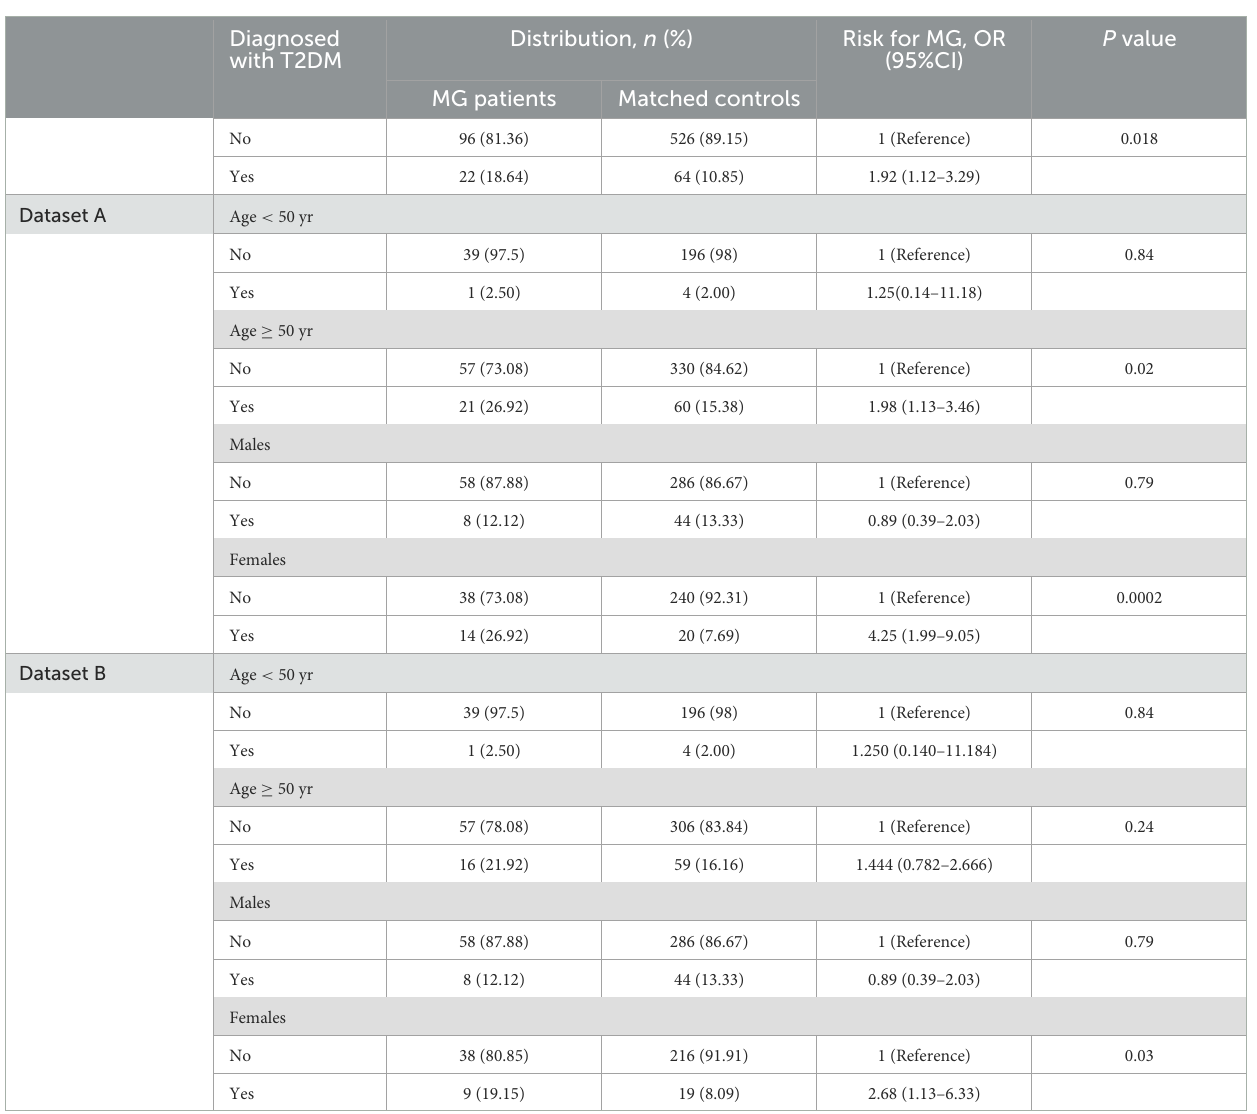
TABLE 2 Distribution of T2DM and associated risk for MG in datasets A and